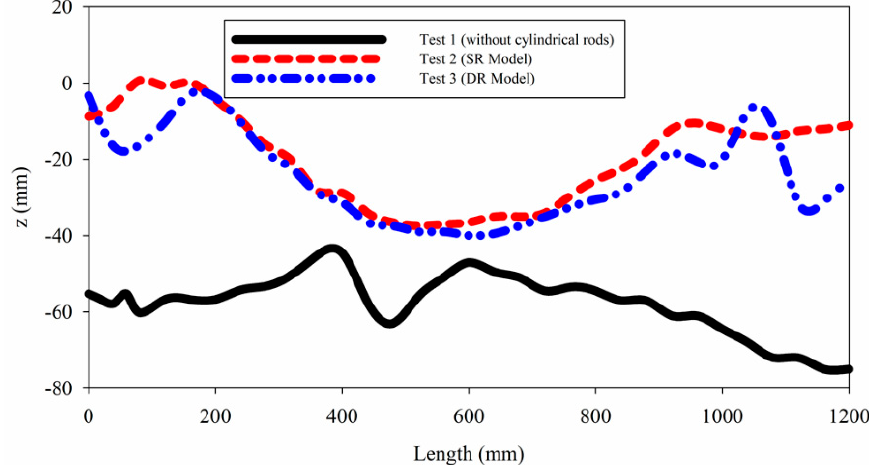
Figure 7. Longitudinal profile of the thalweg in the test section of the bend (Tests 1, 2 and 3).